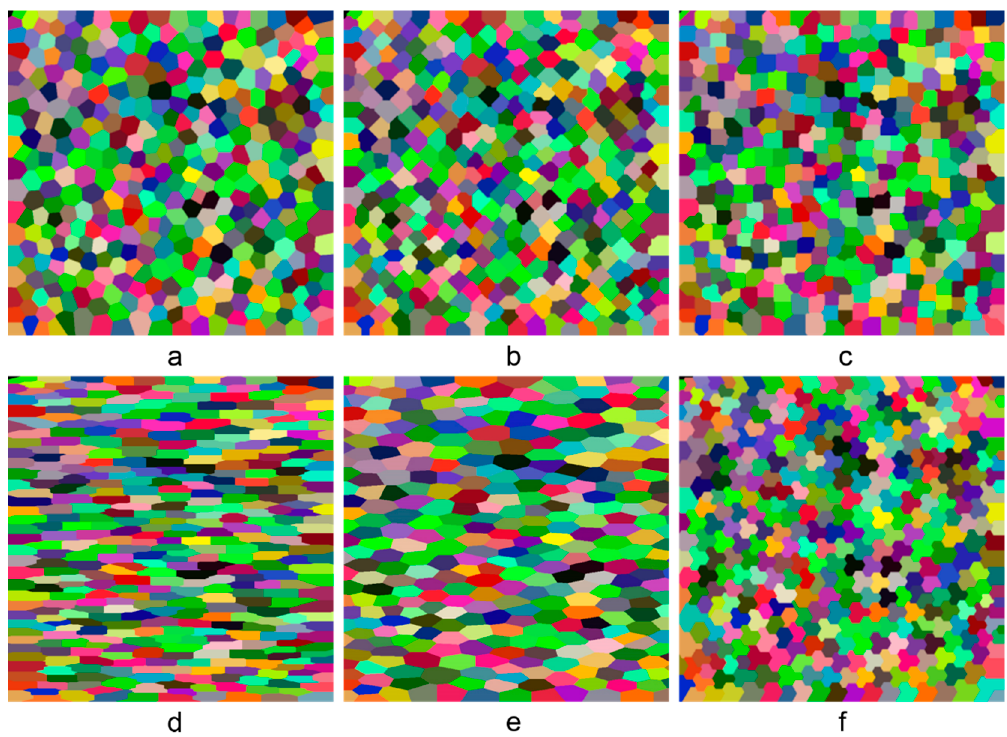
Figure 3. Voronoi diagrams generated with different distance function: ( a ) L 2 -metric distance; ( b ) Manhattan distance; ( c ) Chebyshev distance; ( d ) Chebyshev distance with axial scale; ( e ) L 2 -metric with axial scale; and ( f ) equidistant line distance. The partitioned regions are presented in different